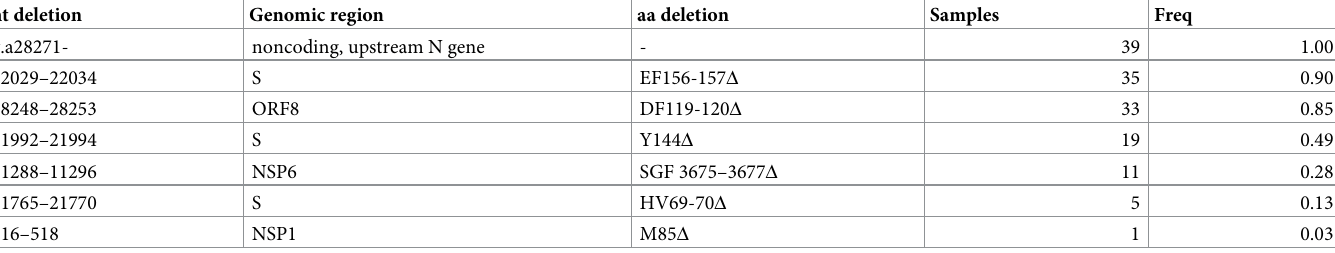
Table 5. The frequency of deletions identified among the SARS-CoV-2 isolates (n = 39) in Uzbekistan. nt deletion Genomic region aa deletion Samples Freq g.a28271- noncoding, upstream N gene - 39